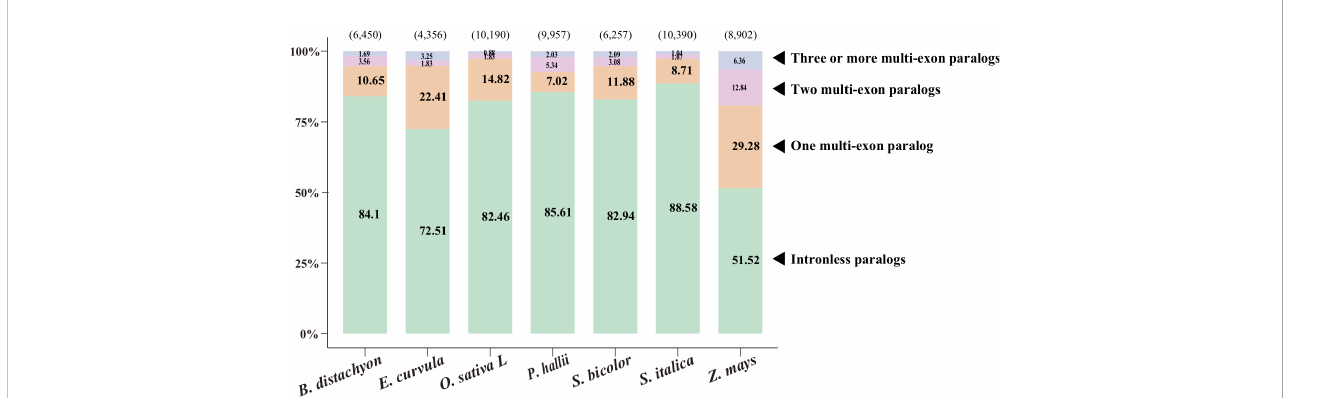
FIGURE 1 Paralogy of intronless genes (IGs). Coding sequences of IGs were aligned to their paralogs, including intronless paralogs and one, two, and three or more multiexon paralogs. The number of IGs is indicated in parentheses above each bar, whereas the percentages of mapped IGs are provided on the bar. The source data are provided in Supplementary Table S1.